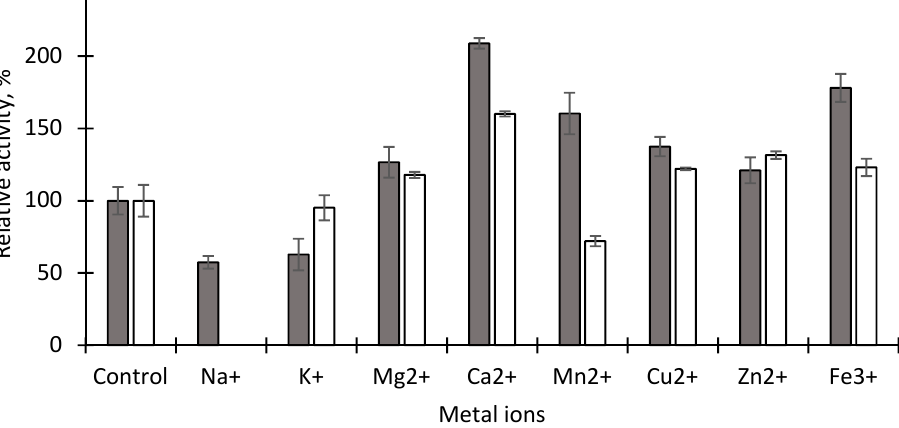
Figure 9. Effect of various metal ions on immobilized EstD9 activity. Relative activity was measured after pre-treatment with 1 mM (grey bars) and 5 mM of metal ions (white bars) for 30 min. The untreated sample was taken as the control with 100% relative activity. Error bars represent standard deviations ( n = 3).